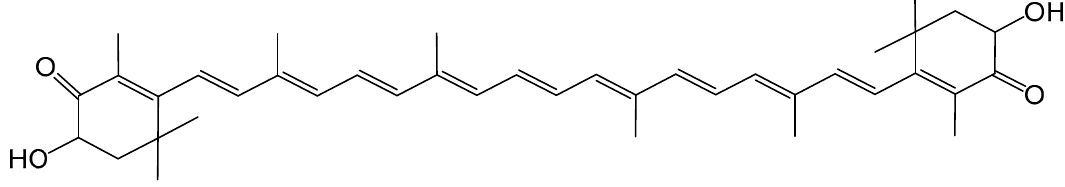
Figure 1. Chemical structure of Astaxanthin (AST).